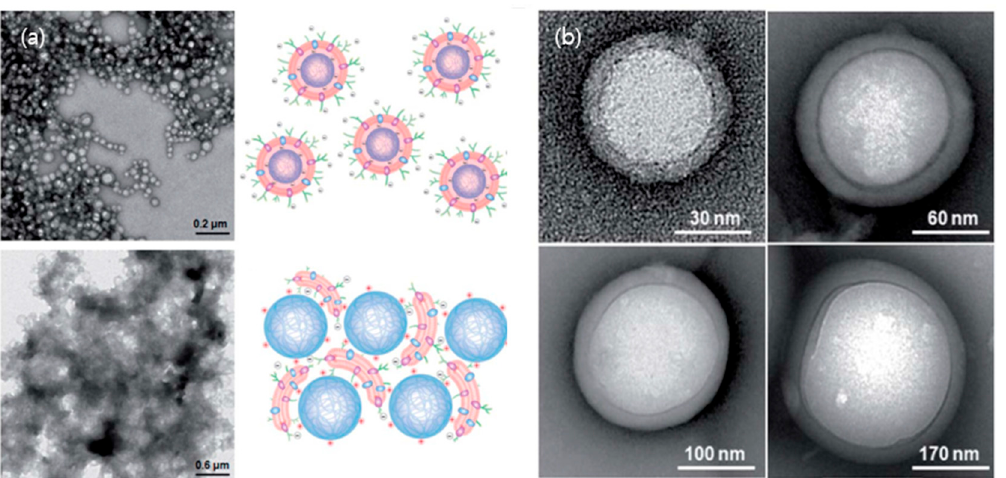
Figure 3. ( a ) The effect of surface charge of particles on RBC membrane coating. The upper left corner shows a TEM image of negatively charged polymeric particles extruded from RBC membranes while the upper right corner illustrates the electrostatic interaction between negatively and asymmetrically charged RBC membranes with negatively charged polymeric cores. The opposite case, positively charged polymeric cores with RBC membranes is shown in a TEM image (bottom left) as well as its possible electrostatic interactions (bottom right); ( b ) The effect of substrate particle curvature induced by particle sizes on RBC membrane coating. Representative TEM images show RBC-NPs with a variety of NP cores sized 65, 120, 200, and 340 nm in diameters, indicating uniform RBC cloaking on various sizes of NPs. Adapted with permission from [90] copyright 2011, Royal Society of Chemistry, Nanoscales.